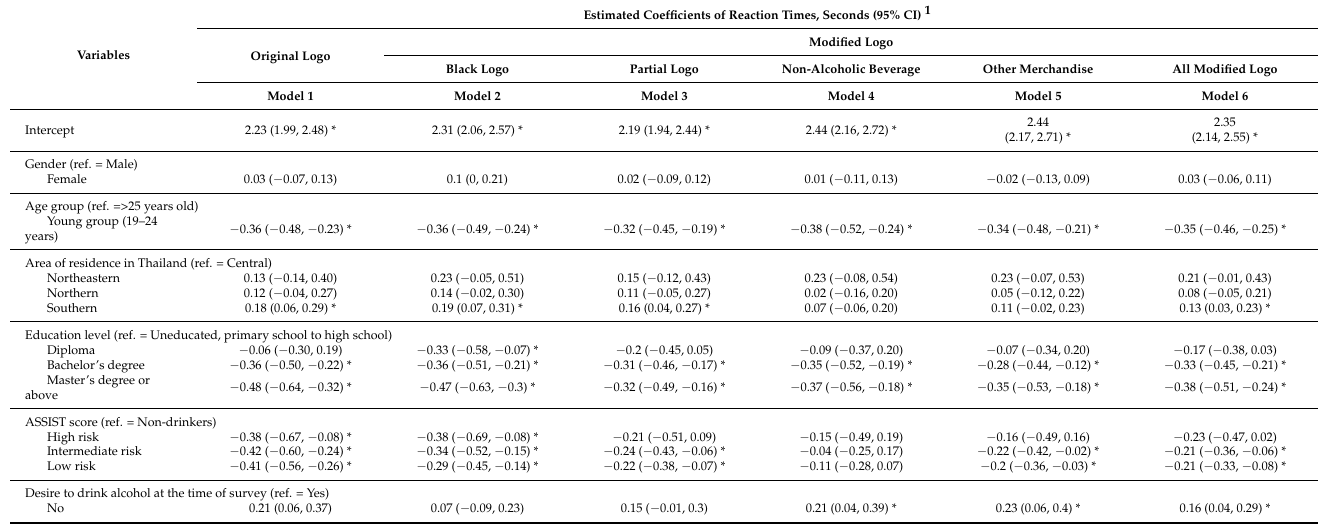
Table 3. Subgroup analysis of alcohol recognition using alcohol recognition using reaction time to each type of